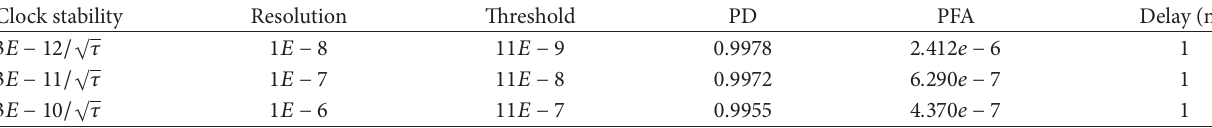
Table 3: Detection performance of phase jumping for different clock stability.